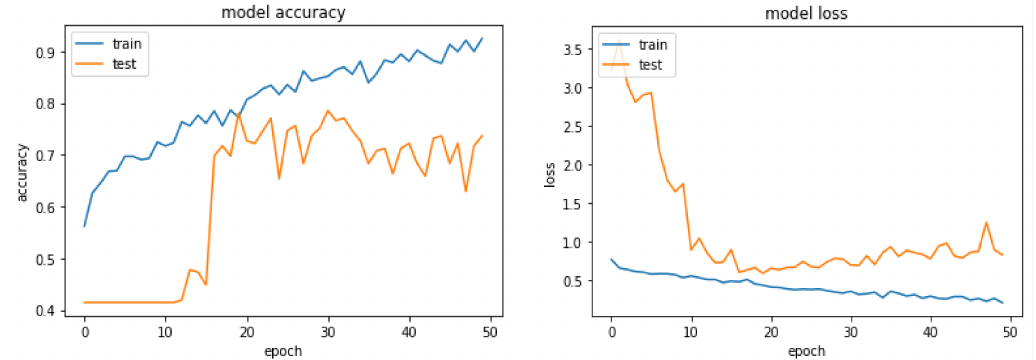
Figure 20. Model accuracy and model loss plots of the VGG-19 model for image sentiment prediction.